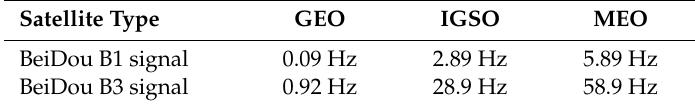
Table 2. The max Doppler shift of the BeiDou B1 / B3 signals’ ranging